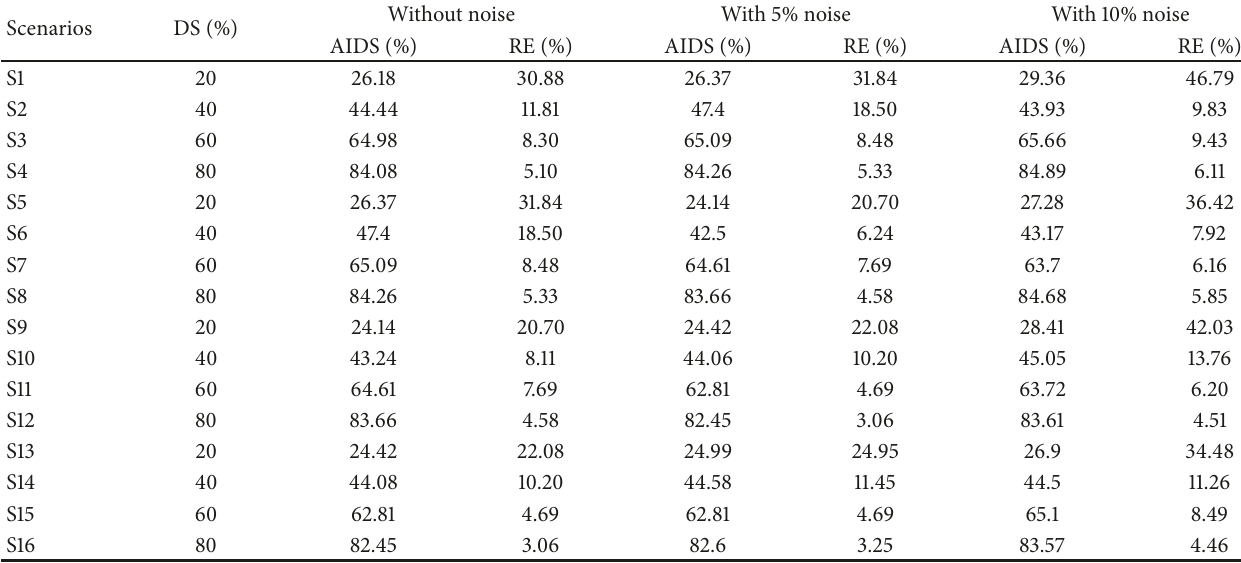
Table 5: Average of identified damage severities based on WPEV and SVM.